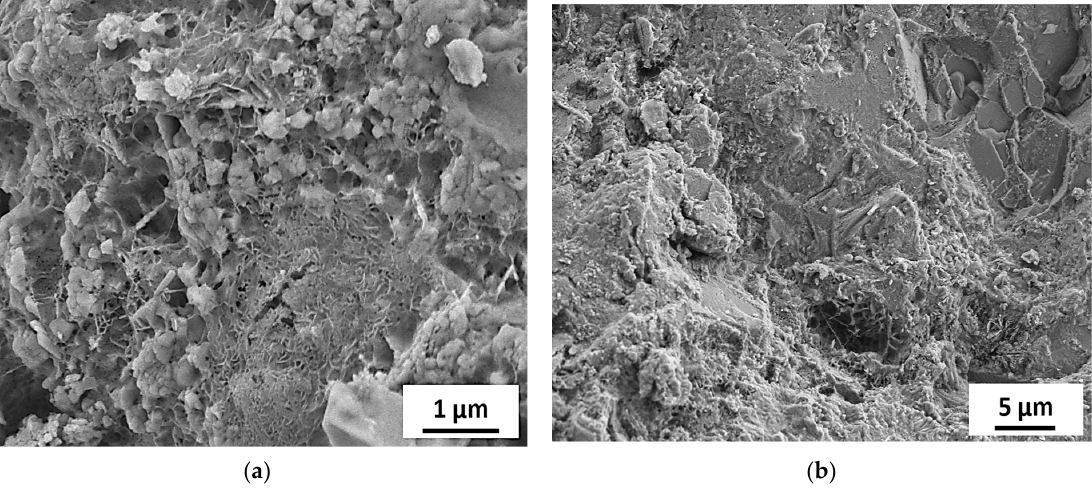
Figure 17. SEM images of specimens incorporating various aggregates ( a ) Abbotabad source aggre- gates ( b ) Swabi source aggregate.